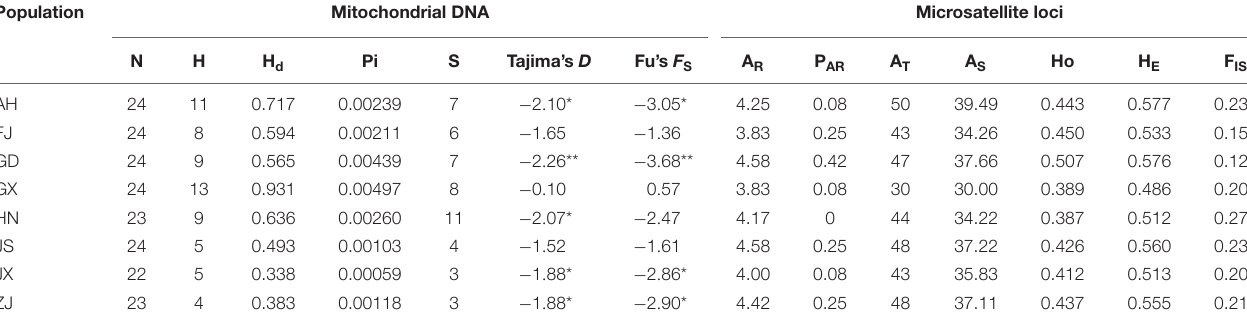
TABLE 3 | Population genetic diversity of Phyllotreta striolata collected from southern China.